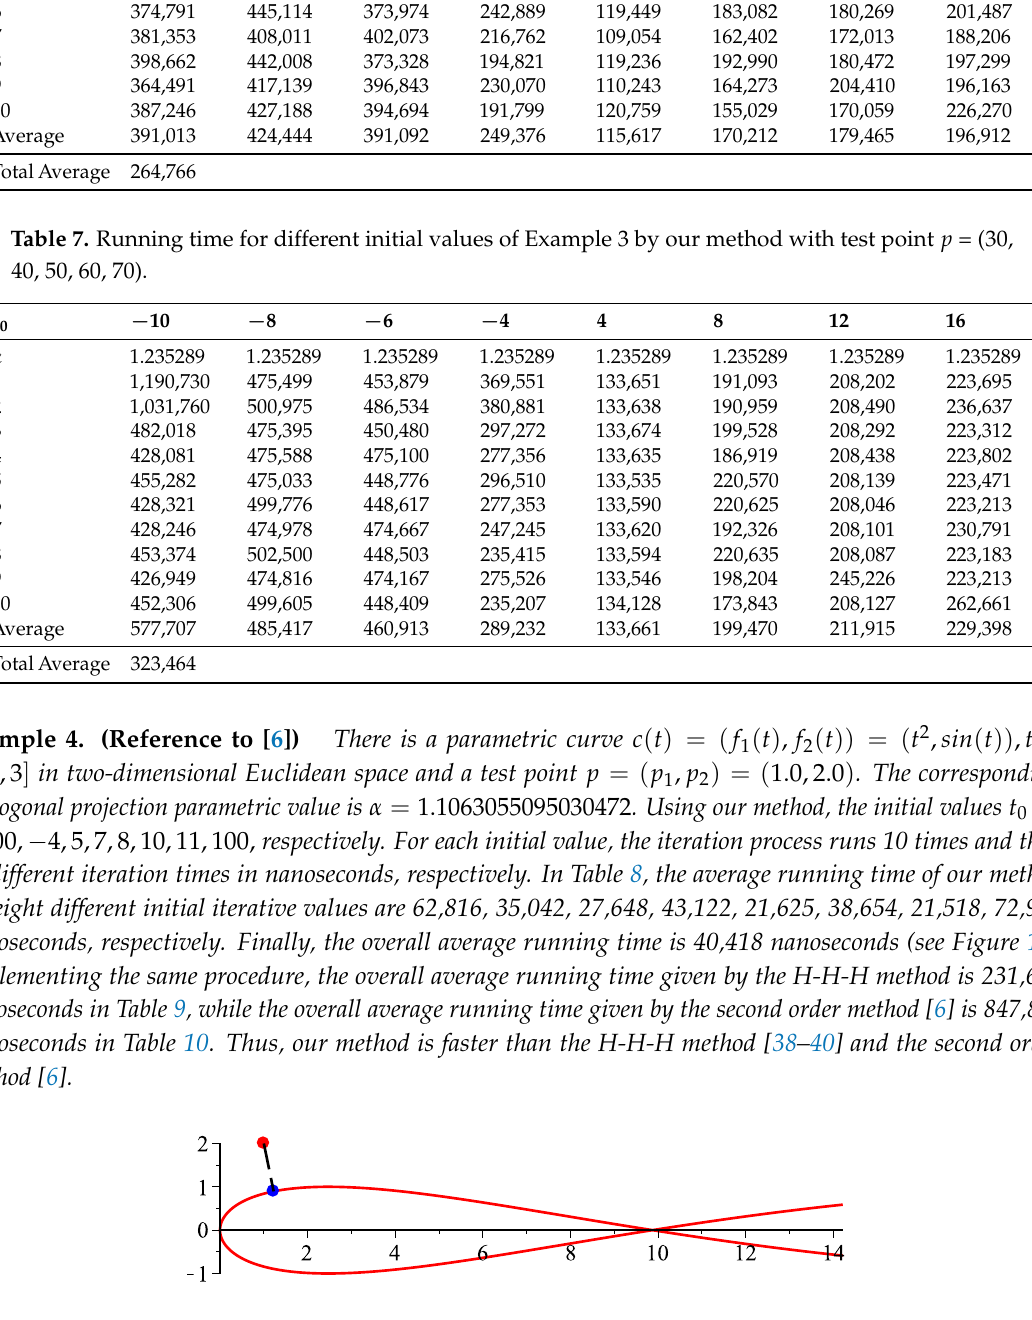
Figure 10. Geometric illustration for Example